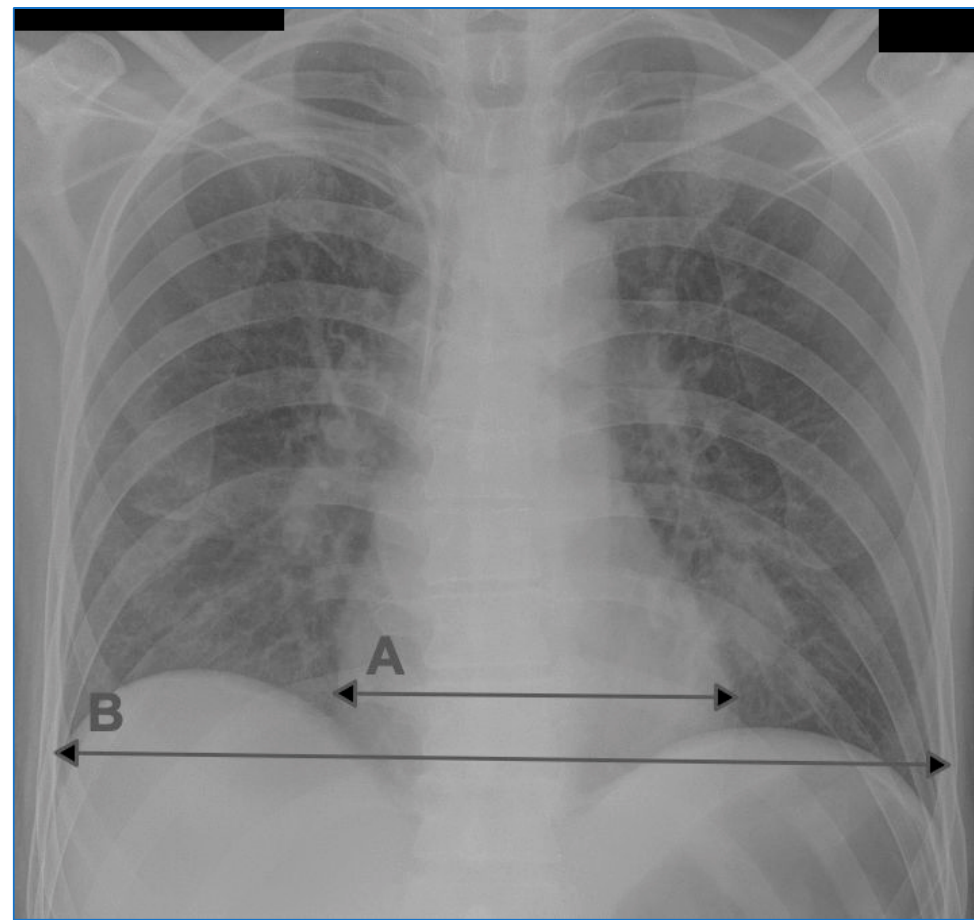
Figure 1. An example of CTR measurement on a chest radiograph in the AP projection. A: transverse dimension of the heart silhouette, B: transverse dimension of the chest.